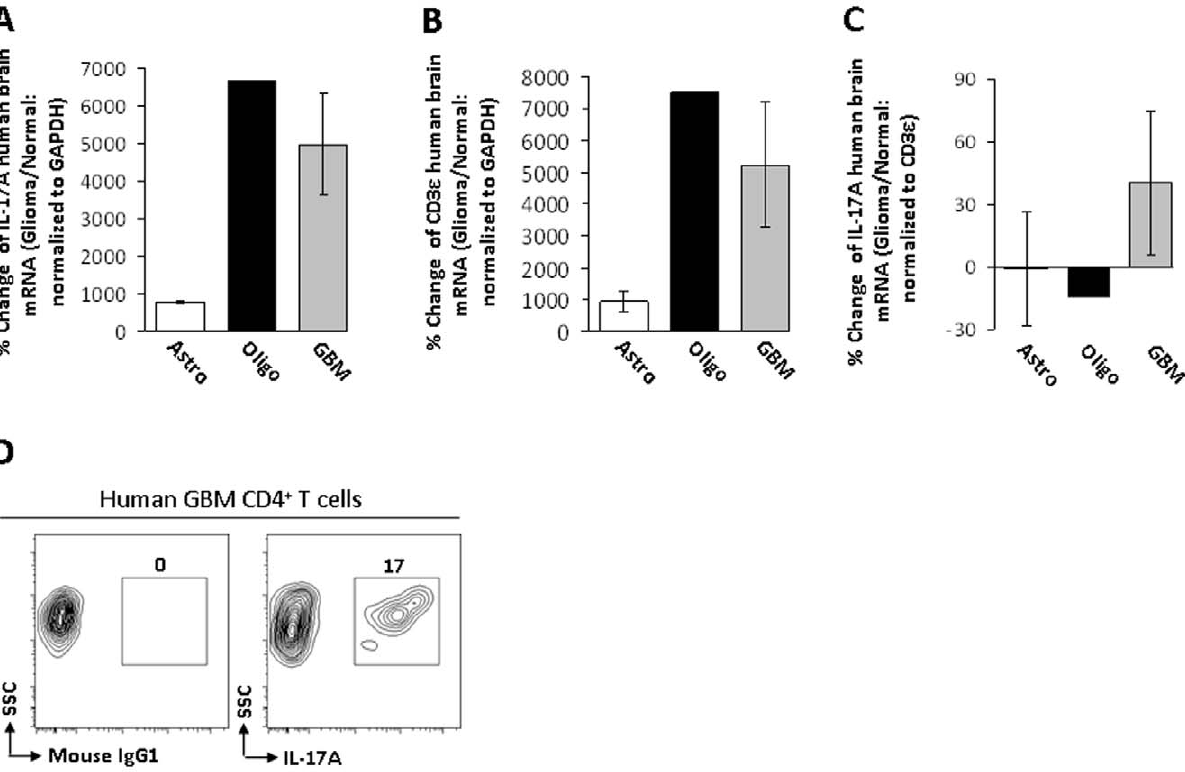
Figure 4. Th17-related mRNA expression levels and Th17 cells in human glioma. (A) IL-17A mRNA levels are displayed as the percent change between the glioma group (Glioma) and normal human brain (Normal), normalized to GAPDH. (B) CD3 e mRNA levels are displayed as the percent change between the glioma groups (Glioma), astrocytoma (grade 2; Astro), oligodendroglioma (grade 3; Oligo), glioblastoma multiforme (GBM) and normal human brain (Normal), normalized to GAPDH. (C) IL-17A mRNA levels are displayed as the percent change between the glioma groups (Glioma), astrocytoma (grade 2; Astro), oligodendroglioma (grade 3; Oligo), glioblastoma multiforme (GBM) and normal human brain (Normal), normalized to CD3 e . (D) Analysis of GBM for CD4 + IgG1 + (isotype control) or CD4 + IL-17A + cells. Flow cytometry data are representative of at least 2 independent GBM patient specimens. Bar heights represent means ( 6 SEM).